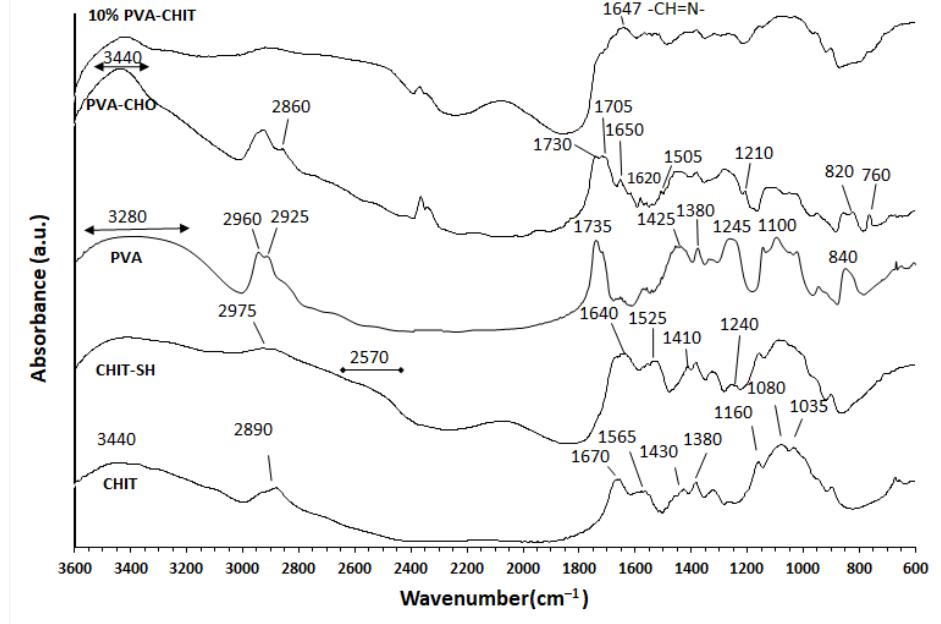
Figure 2. FTIR spectra of initial PVA, 4-formyl benzoate-PVA (PVA-CHO), initial CHIT, 3-mercaptopropionate CHIT (CHIT-SH), and PVA-CHO/CHIT-SH hydrogel.